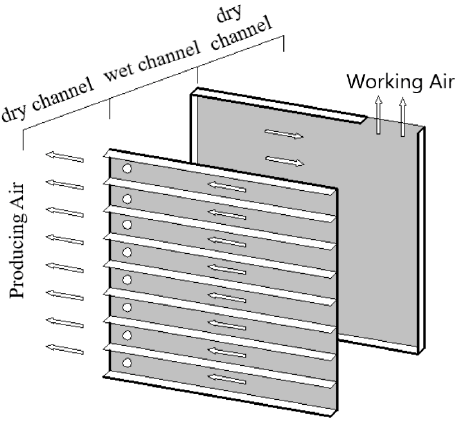
Figure 1. Structure of compound DPIE cooler.